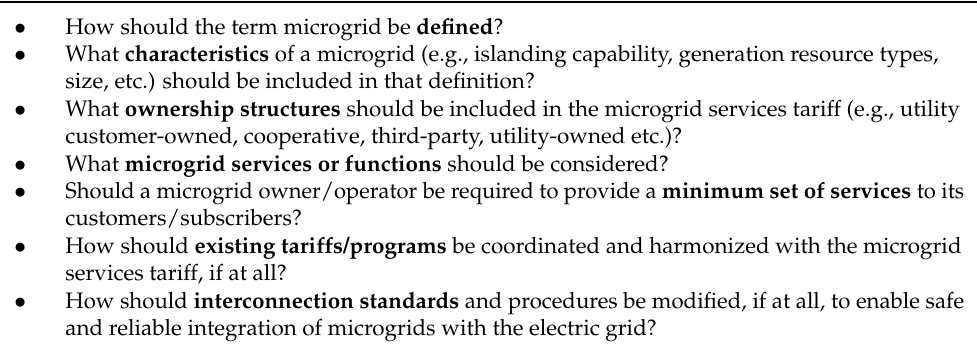
Table 2. Preliminary policy questions in Hawai‘i’s microgrid services tariff regulatory